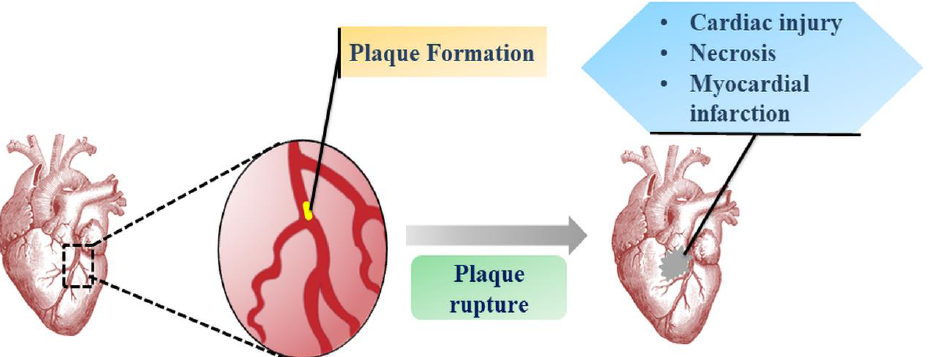
Figure 1. Pathogenesis of myocardial infarction (MI). The plaque formation in coronary artery reduces blood flow and after plaque rupture the developed blood clot leads to permanent damage of cardiomyocytes causing infarction.